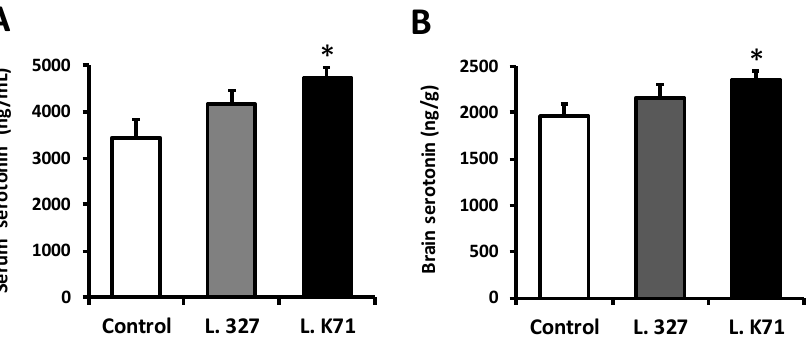
Figure 3. Effect of prolonged diet supplementation with Lactobacillus strains on the serotonin levels in the blood serum ( A ) and brain ( B ) of SAMP8 mice fed for 43 weeks diets containing Lactobacillus strains. Serotonin concentrations were measured by ELISA. Data are expressed as mean ± SEM; n = 8 mice per group; * p < 0.05 vs. the control group.